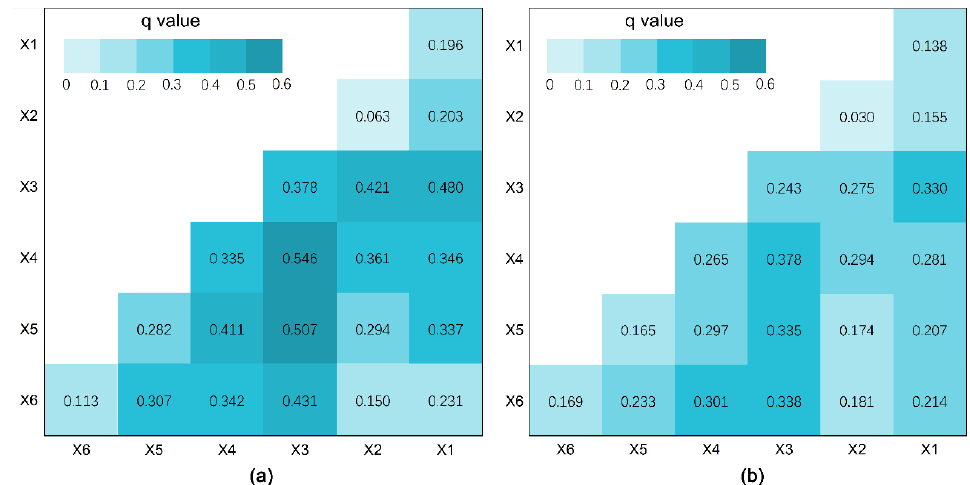
Figure 7. The interactions between two explanatory variables for the variation of sprawl index on residential land: ( a ) The q -statistics calculated by interaction detector in 2000; ( b ) The q -statistics calculated by interaction detector in 2010.